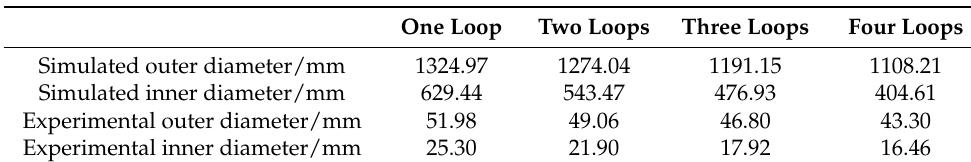
Figure 16. The inner hole variation of the shrinkage ratio experiment: ( a ) one loop; ( b ) two loops; ( c ) three loops; ( d ) four loops.